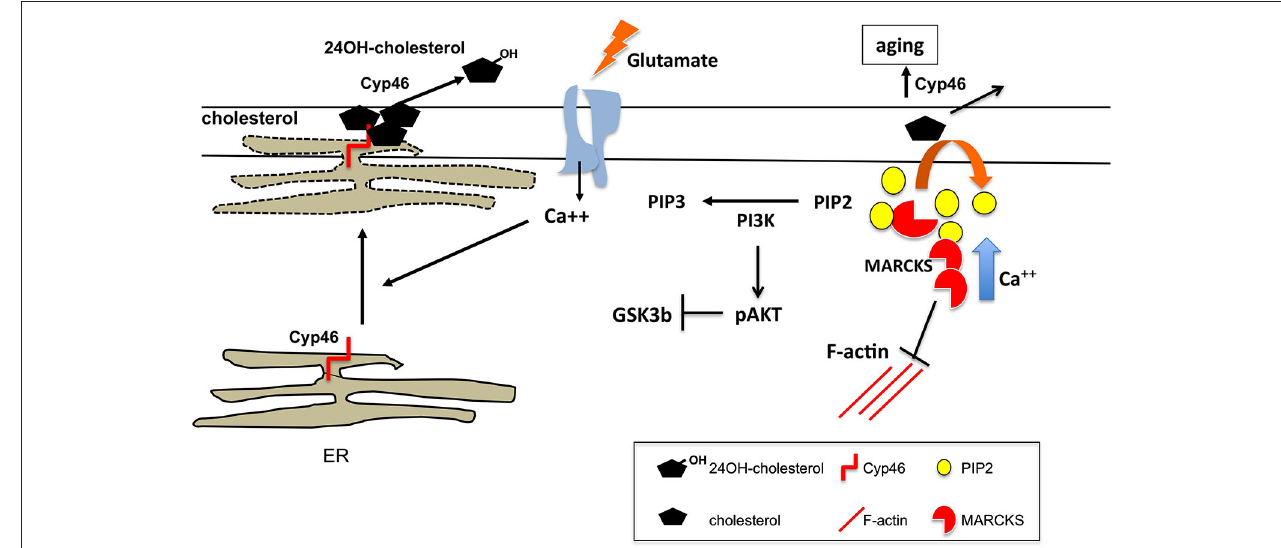
constitutive high intracellular calcium and irreversible cholesterol loss due to lifelong lasting synaptic activity leads to reduced membrane-associated MARCKS, which affects synaptic plasticity by several mechanisms: (1) impaired MARCKS-mediated actin dynamics; (2) reduced membrane clustering of PIP2; and (3) high PI3K activity resulting in reduced glutamate-mediated Akt dephosphorylation and GSK3 β activation. The later contributes to the impaired AMPARc internalization and LTD in aged